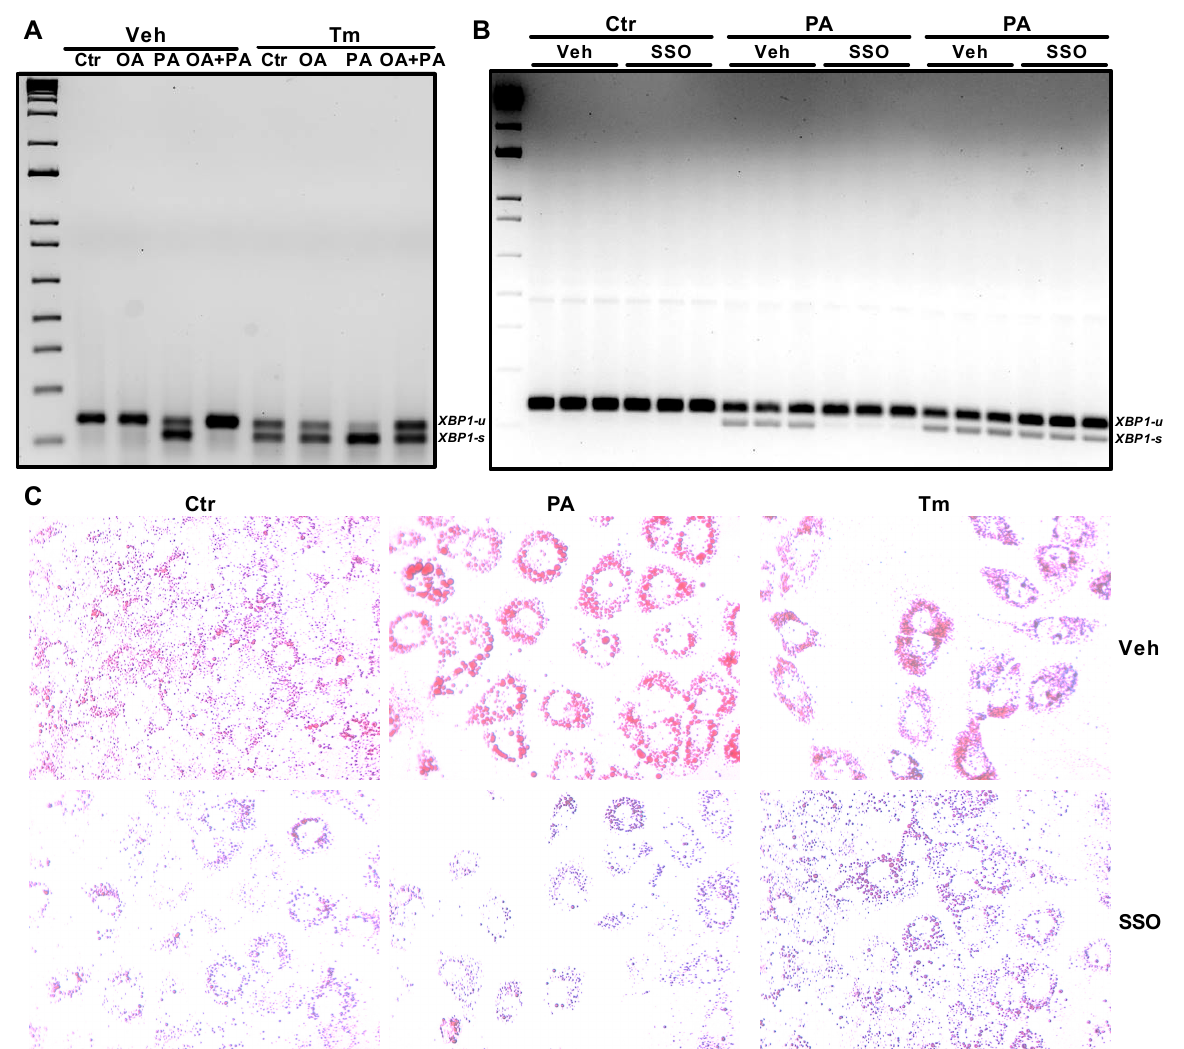
Figure 6. Oleate and SSO prevents palmitate induced and not tunicamycin induced XBP1 splicing in Huh-7 cells. Huh-7 cells were treated without (Veh) or with 10 mg/mL of tunicamycin for 6 h. Cells were washed and incubated without (Ctr) or with 0.2 mM of oleate (OA), palmitate (PA) or a combination of both (OA+PA) for 16 h ( A ). In a separate experiment, Huh-7 cells were pre-treated with vehicle (Veh) or 100 mM of sulfo- N -succinimidyl oleate sodium (SSO) for 6 h. After 6 h, fresh media was added and cells were treated without (Ctr) or with either 0.2 mM palmitate (PA) or 10 mg/mL of tunicamycin (Tm) for another 17 h in the absence (Veh) or presence of 100 mM of SSO. Cells were used for the extraction of total RNA. Unspliced (u) and spliced (s) forms of XBP1 mRNA were measured by RT-PCR ( B ). Lipid accumulation in SSO treated Huh-7 cells was determined after staining the cells with Oil Red O using the brightfield microscopy ( C ). Representative photographs of each condition is shown above in the